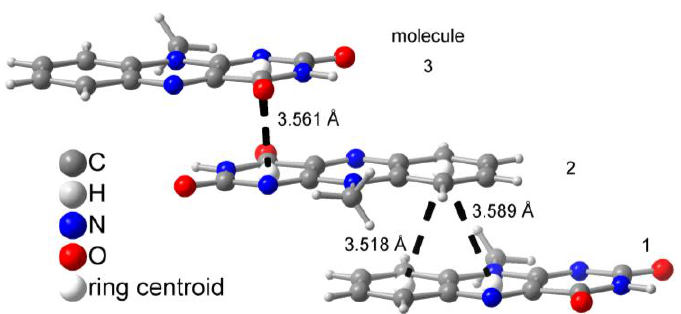
Figure 7. π − π stacking modes in crystalline MIA with centroid-centroid distances (graphics were drawn from the deposited cif file with CCDC Refcode MISALX [60]). The numbers 1, 2 and 3 differentiate the molecules for their different stacking interactions (see text.)